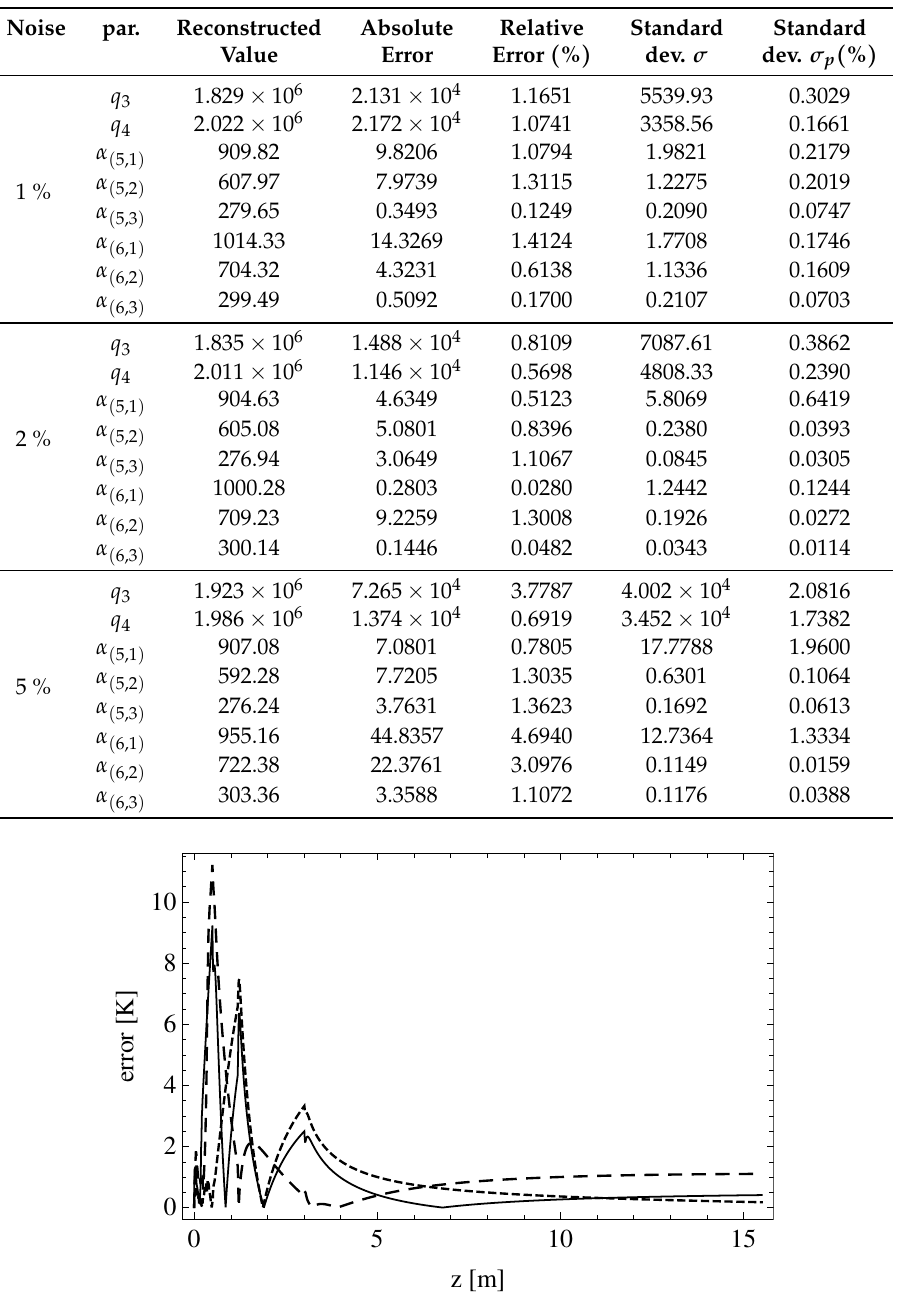
Figure 10. Absolute error of temperature reconstruction in the control points for measurements read at every 0.01m and with a 5% error (four steps